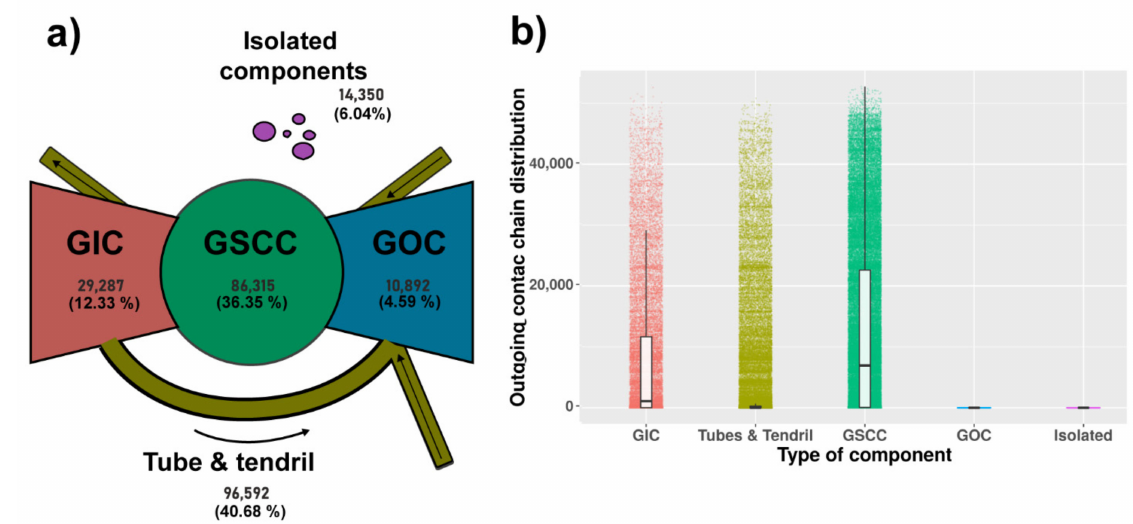
Figure 3. ( a ) Bow-tie structure of a directed graph. The GWCC was separated into GSCC, the relative in- and out- components, tendrils, and tubes. Adapted from References [5,26]. ( b ) Each little point represents the outgoing contact chain distribution by type of component for all study periods, the white boxes represent a boxplot of components